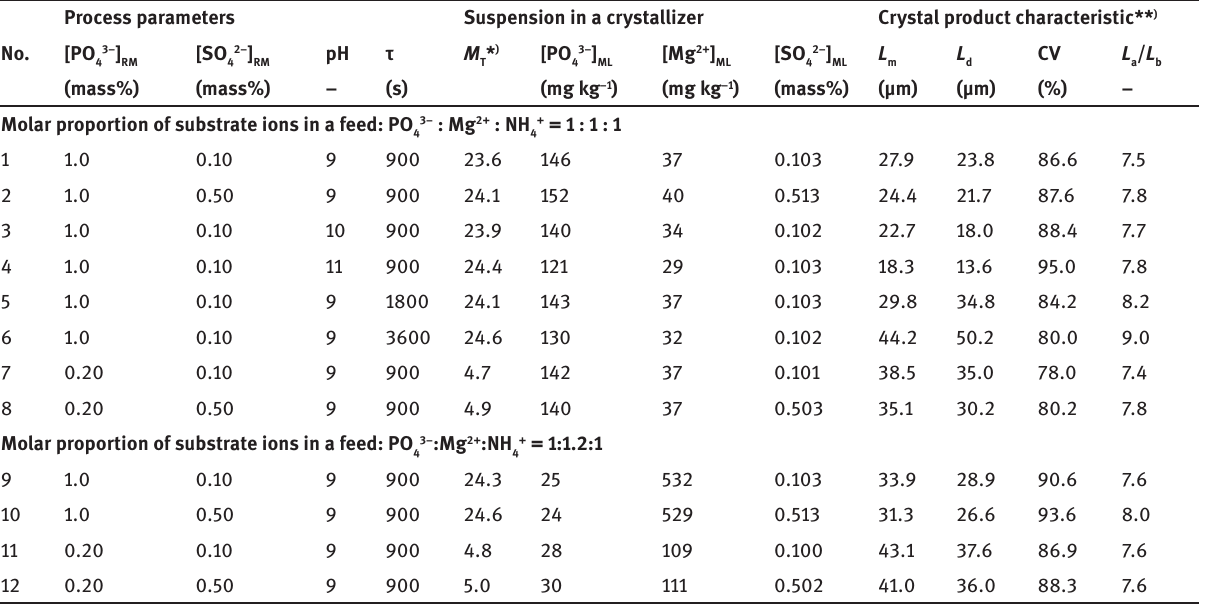
Table 2: Effects of feed concentration of sulphate(VI) ions and selected technological parameters of continuous struvite reaction crystallization process on the product quality. Process temperature: 298 K.